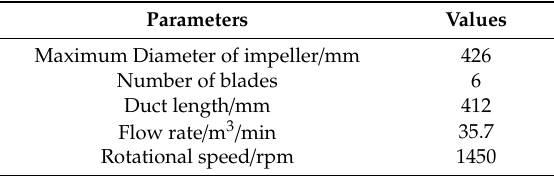
Table 1. Parameters of the mixed flow